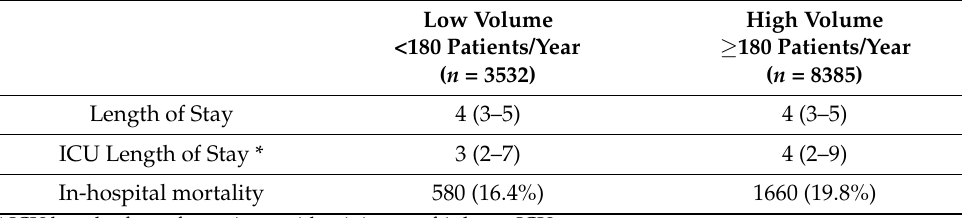
Table 2. Outcome characteristics divided by low and high hospital volume (ISS >